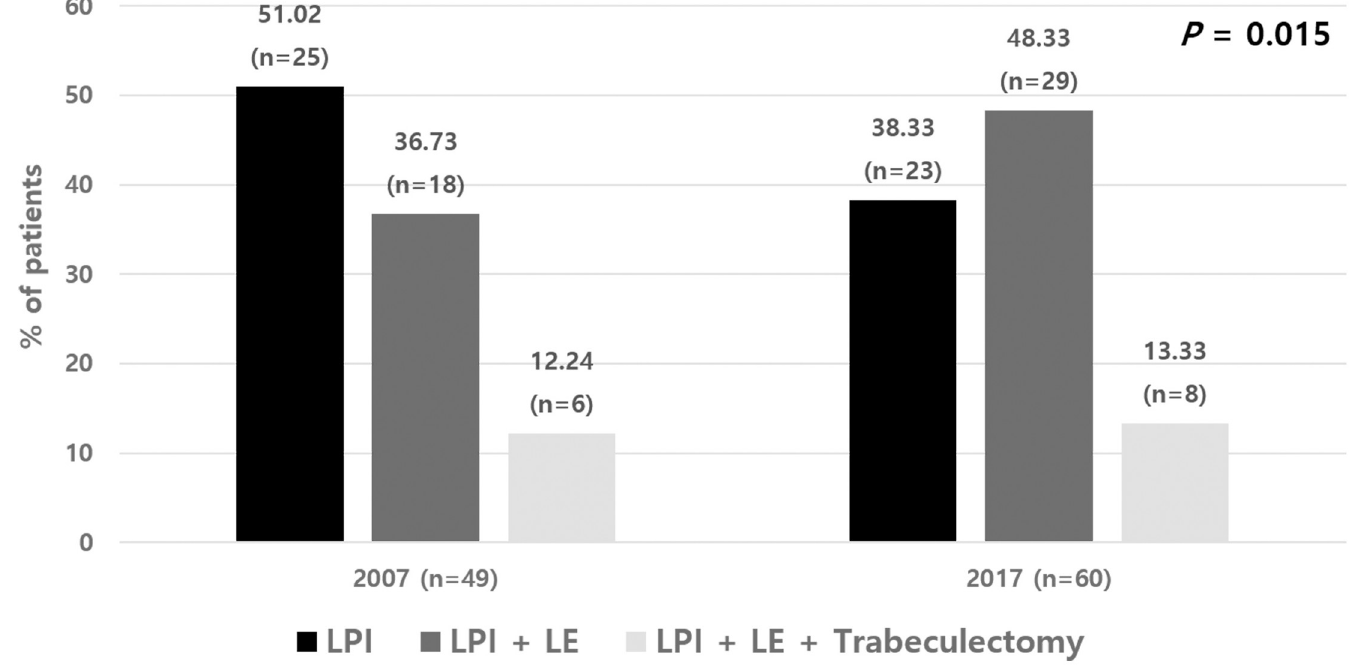
Fig 2. Comparison of treatment modalities between patients with APAC in 2007 and 2017. In 2007, of 49 patients, 25 patients (51.02%) underwent LPI only, 18 patients (36.73%) required further LE, and 6 patients (12.24%) required further trabeculectomy. However, in 2017, of 60 patients, only 23 patients (38.33%) underwent LPI, with 29 (48.33%) and 8 (13.33%) patients received LE and trabeculectomy, respectively, for the treatment of APAC ( P = 0.015). APAC = acute primary angle closure; LE = lens extraction; LPI = laser peripheral